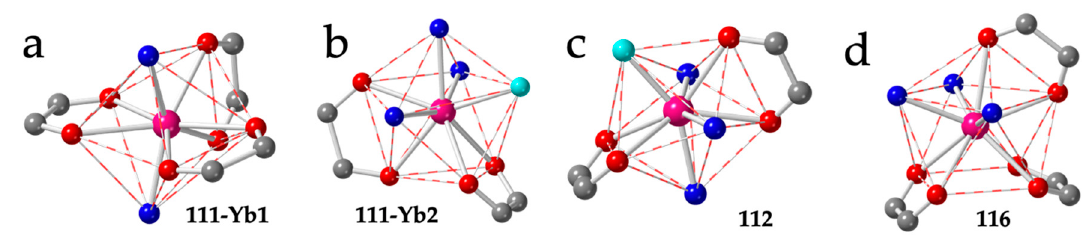
Figure 15. Coordination environment of the Yb1 ( a ) and Yb2 ( b ) ions in compound 111 . ( c ) Coordination environment of the Yb(III) ion in compound 112 . ( d ) Coordination environment of the La ion in compound 116 . Colour code: Ln = pink, C = grey, O anilato = red, O solvent = blue and O coligand = light blue. The layers in compound 111 are formed by distorted hexagons with six anilato ligands (with a maximum Ln ‐ Ln ‐ Ln angle of 144.4°) alternating with rectangles containing four anilato and two dobdc 2 − ligands (with a maximum Ln ‐ Ln ‐ Ln angle of 165.1 º ). The directions of both largest Ln ‐ Ln ‐ Ln